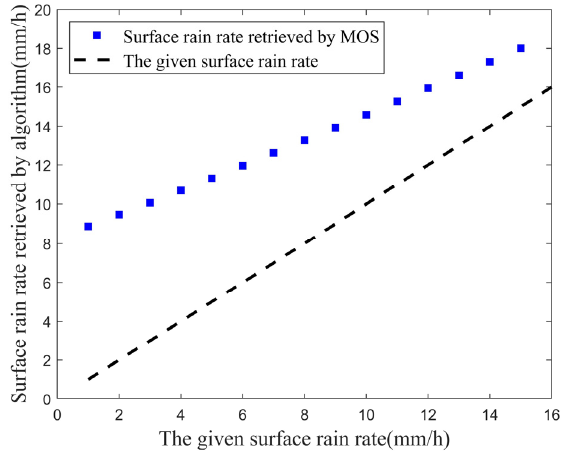
Figure 3. Retrieved surface rain rates by MOS and the given rain rates.